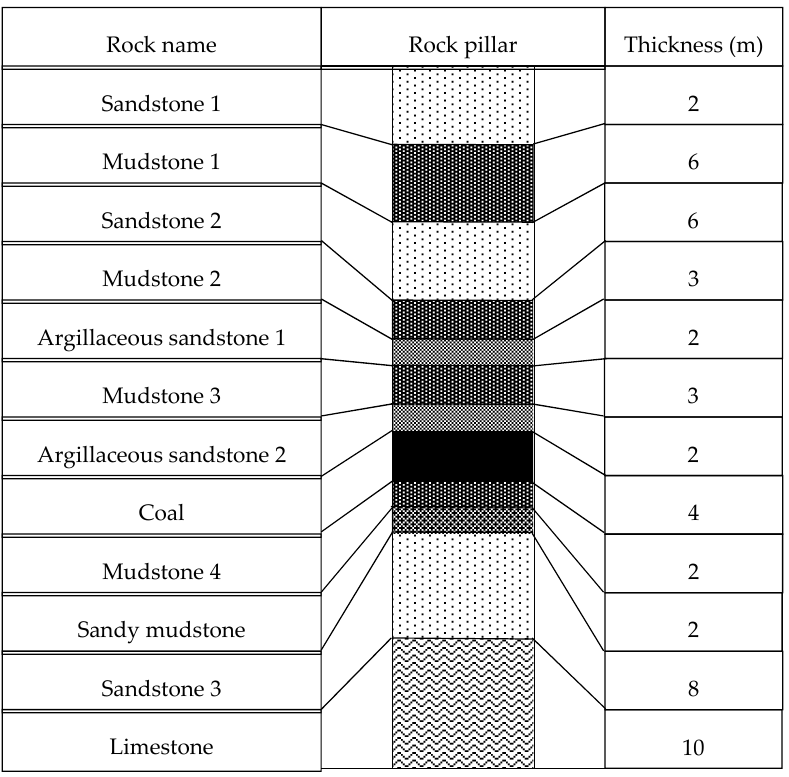
Figure 8. Distribution of the strata in the coal mine.